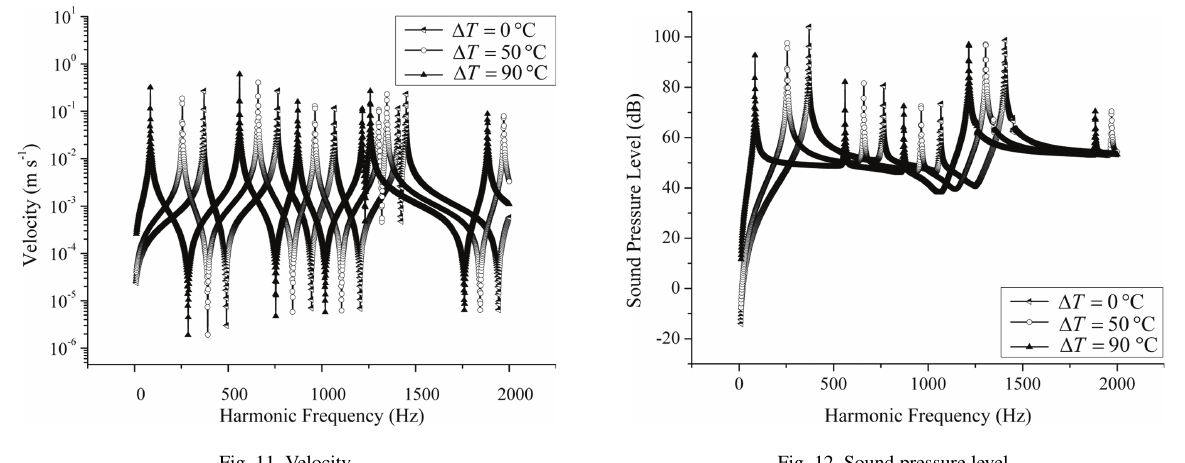
Fig. 11. Velocity. Fig. 12. Sound pressure